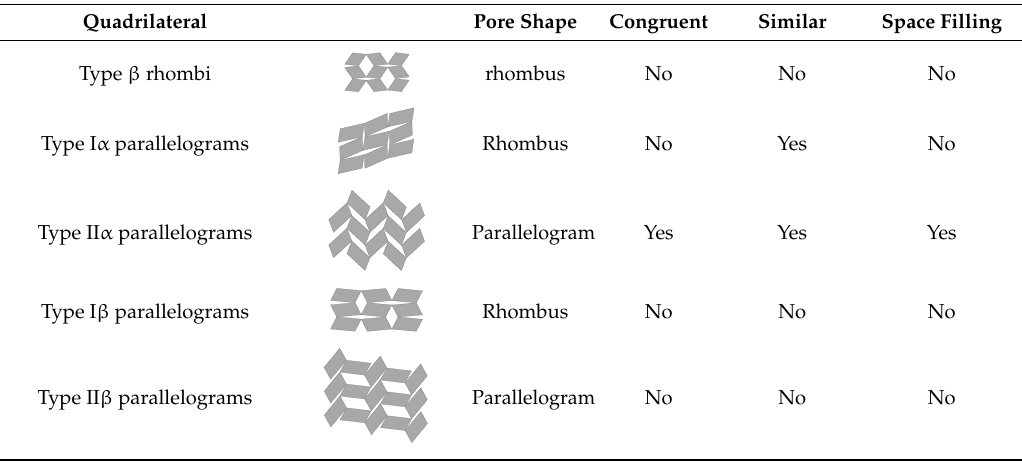
Figure 2. Examples of rigid particles having ( a ) spherical ( b ) pill-box ( c ) drop and ( d ) bullet shapes and the corresponding circular cross-sectional area (indicated by the dashed line) of radius r